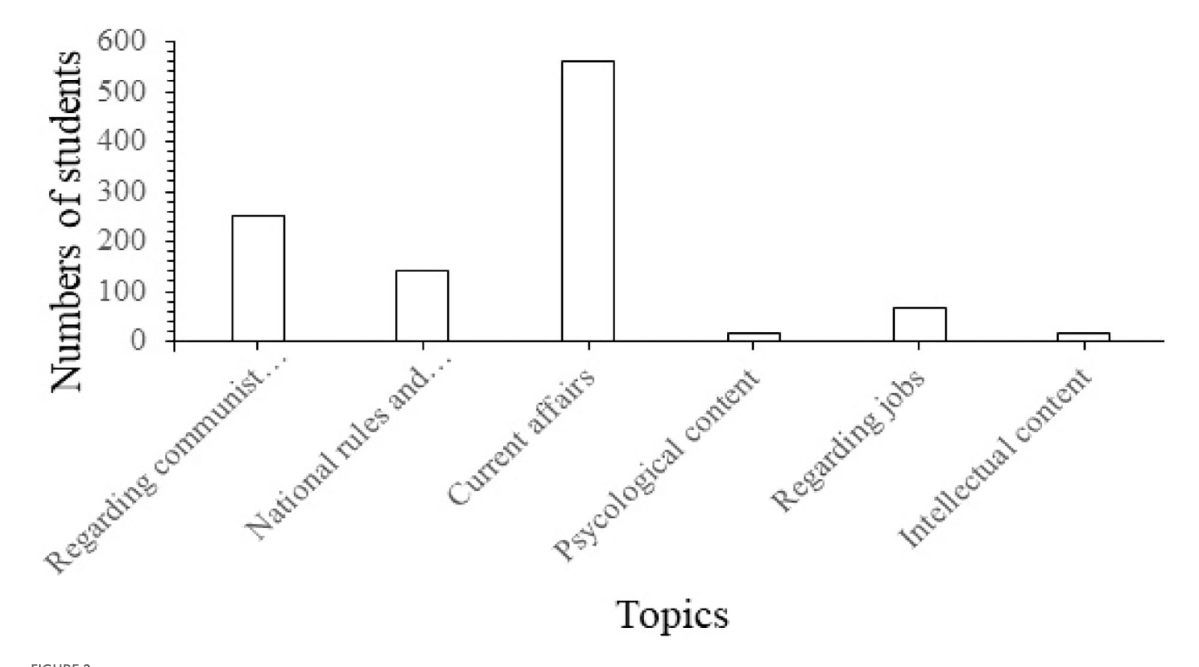
FIGURE2 Ideological and political content of